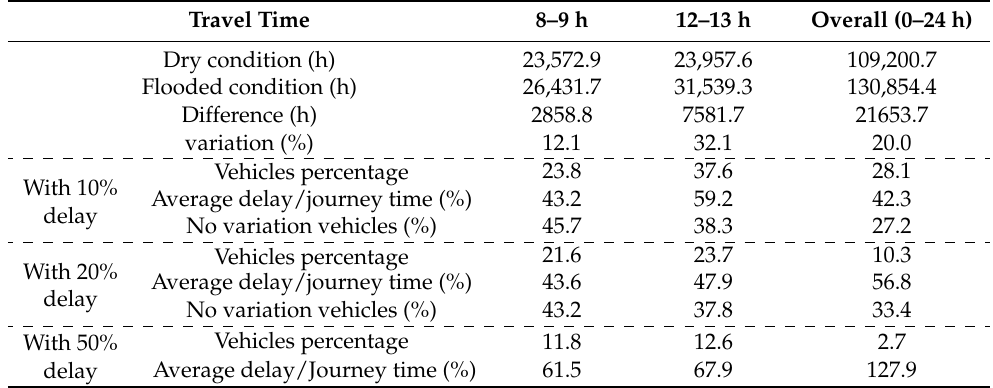
Table 4. Flood effects on travel